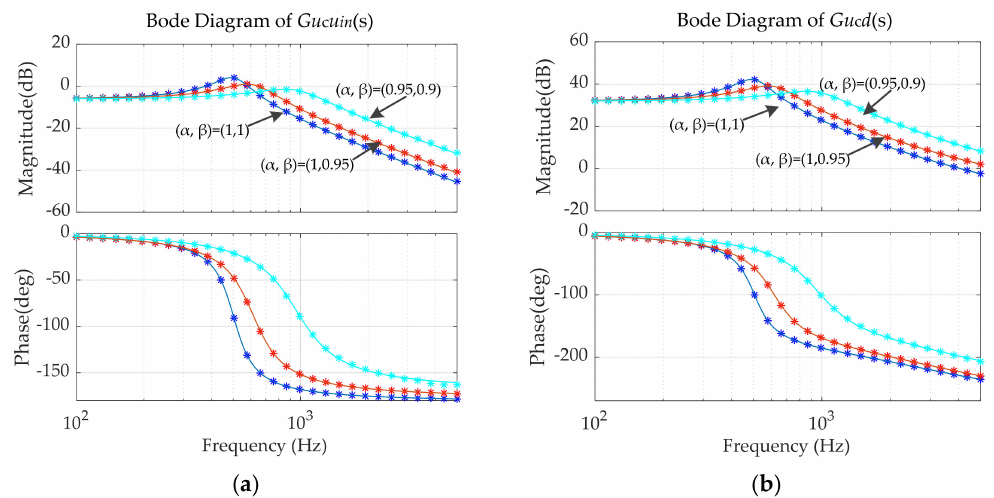
( s ) obtained by theoretical analysis and circuit simulation c u in c d